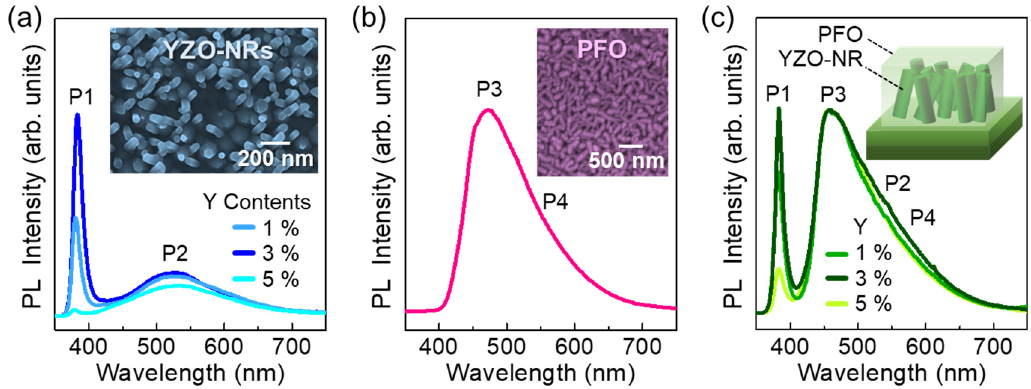
Figure 2. Optical properties of the prepared materials: ( a ) PL spectra of YZO-NRs with the different Y contents (1%–5%), ( b ) PL spectrum of PFO, and ( c ) PL spectra for the hybrid heterostructures of the PFO/YZO-NR (Y: 1%–5%). The inset of ( a ) and ( b ) display the SEM images of YZO-NRs and PFO, respectively; and the inset of ( c ) illustrates the PFO/YZO-NR heterostructure.